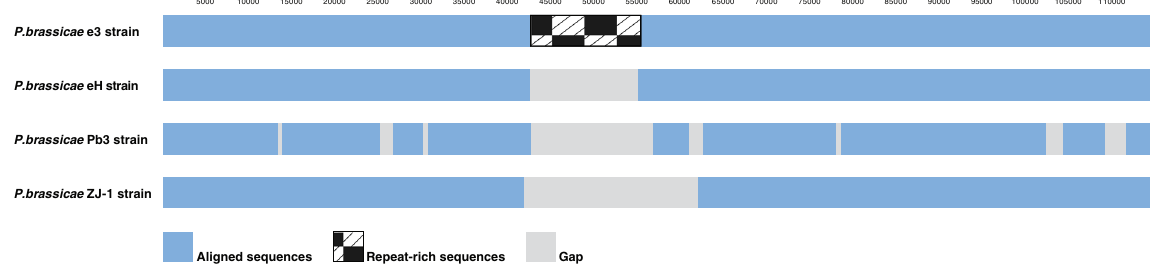
Figure 2. Alignment between four Plasmodiophora brassicae mitochondrial genomes. The illustration is based on mitochondrial genome synteny using the e3 strain (114,663 bp) as a template to which homologous regions identified in eH (102,962 bp), Pb3 (101,103 bp) and the ZJ-1 (93,640 bp) strain were aligned. For details, see Supplementary Fig. S9. The upper line represents sequence coordinates of the e3 mitochondrial